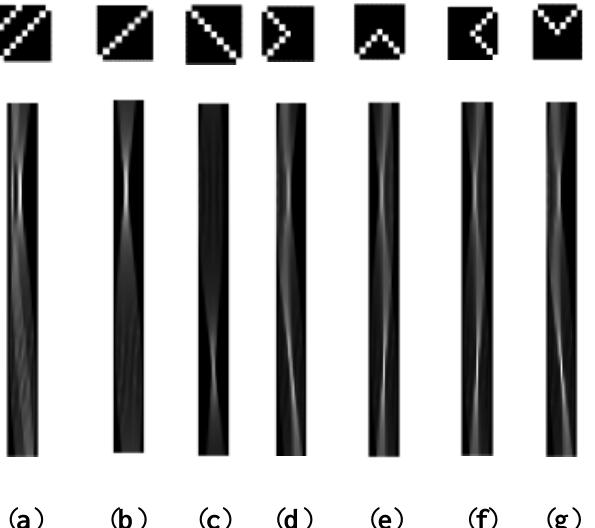
Figure 3. Contour models: ( a ) NCM of double line model (top) with its MPT representation (bottom); ( b ) Diagonal NCM (top) and its MPT representation (bottom); ( c ) Diagonal NCM (top) and its MPT representation (bottom); ( d ) UCM (top) and its PUCM representation (bottom); ( e ) UCM (top) and its PUCM representation (bottom); ( f ) UCM (top) and its PUCM representation (bottom); ( g ) UCM (top) and its PUCM representation